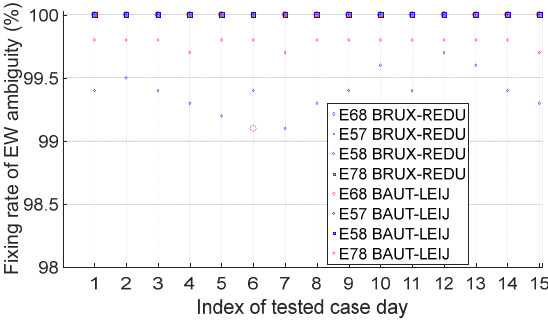
Figure 15. Fixing rate of the GPS extra ‐ wide ‐ lane ambiguity of G25.